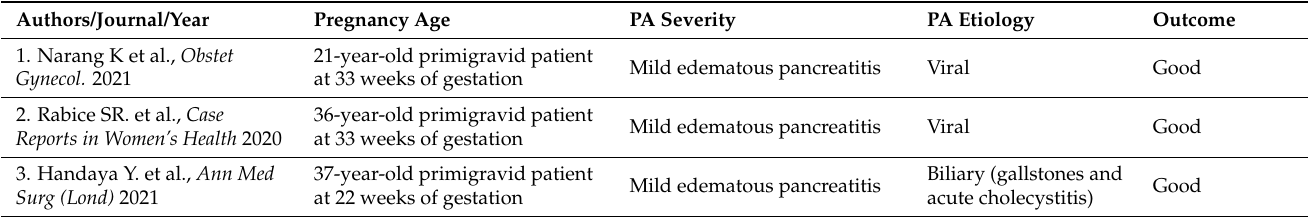
Table 4. Articles related to COVID-19, AP, and